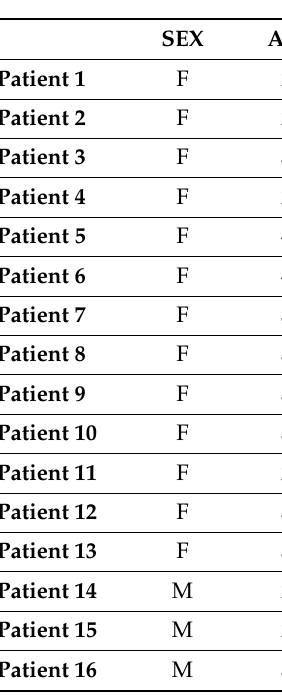
Table 2. Patients’